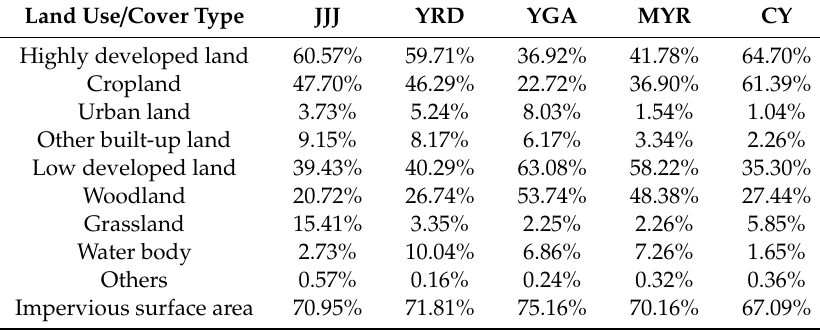
Table 3. Proportion of land use/cover type among megaregions in 2015.